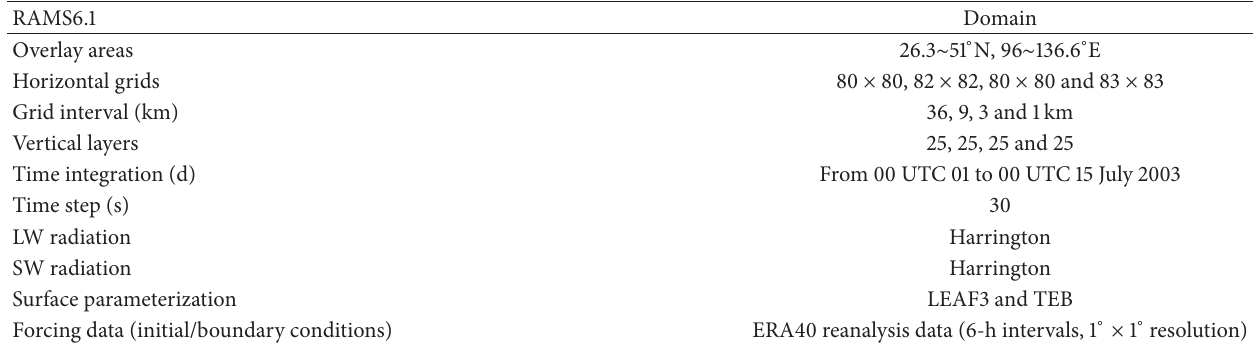
Figure 1: (a) Configuration of the four two-way nested domains used for the TEB-RAMS (LEAF3-RAMS) simulation in this study. The center of the fourth grid represents the metropolitan area of Beijing, and the central position is located in Tian’an Men Tower. (b) Beijing city with the innermost contour representing its most urban region. The red region represents urban category. The legend shows the vegetation types of the USGS land-use data. Table 1: The main simulation parameters in the